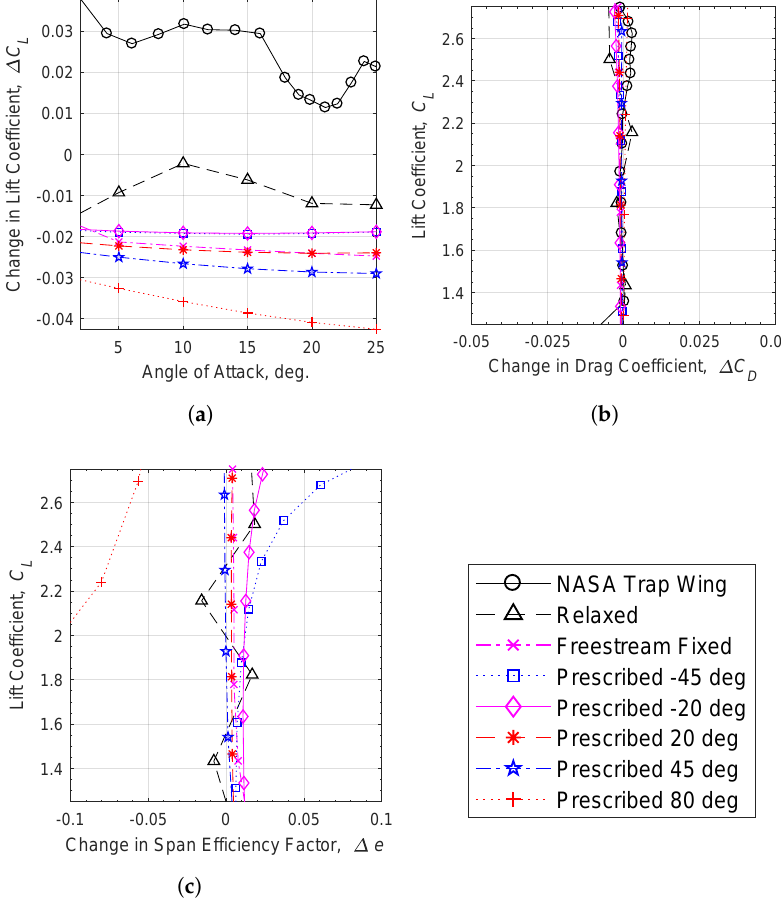
Figure 20. Predicted and experimentally-observed performance changes due to a slotted flap gap size increase, from 1% to 1.5% of the cruise wing chord. ( a ) Lift predictions, ∆ C L = C L , Config 1 − C L , Config 2 ; ( b ) drag predictions, ∆ C D = C D , Config 1 − C D , Config 2 ; ( c ) span efficiency predictions, ∆ e = e Config 1 − e Config 2